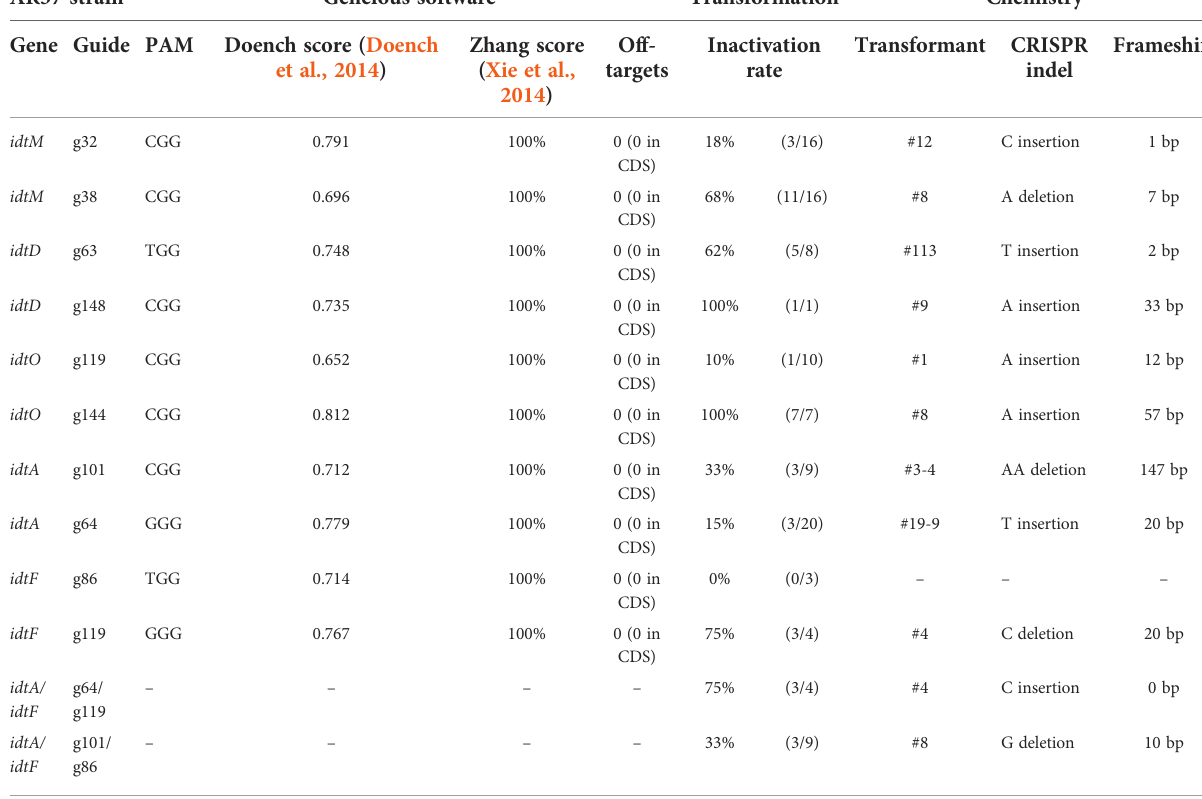
TABLE 1 CRISPR guide